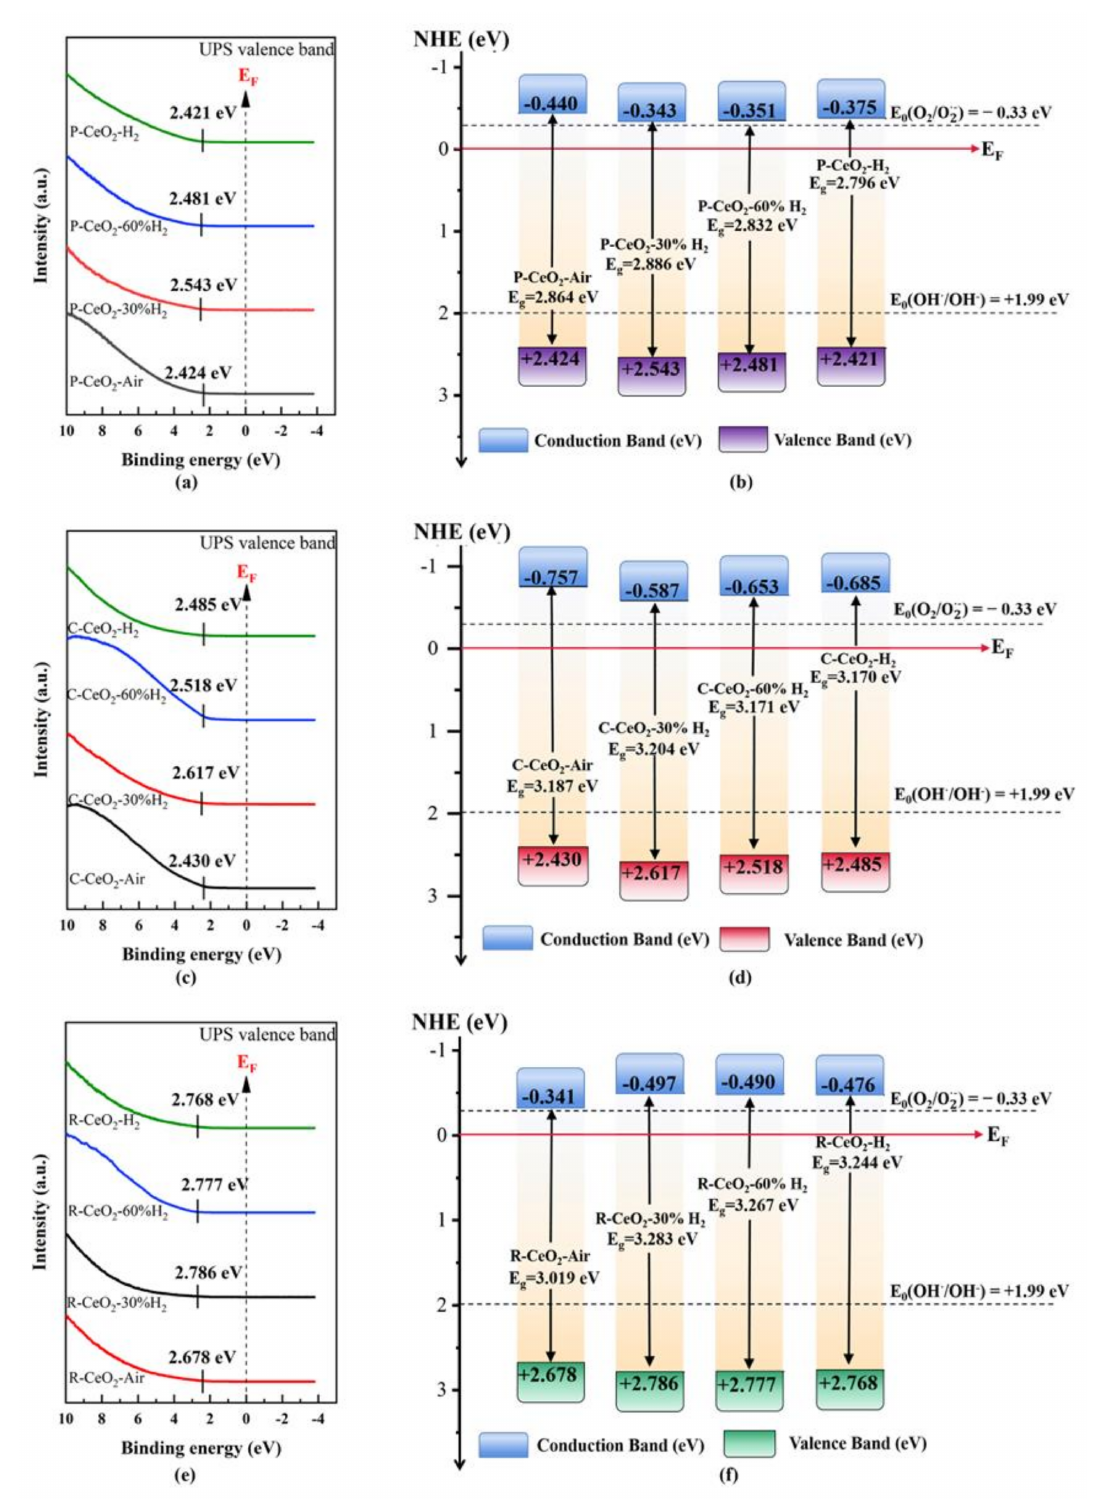
Figure 7. UPS valence band spectra and energy band gap schematic diagram of P-CeO 2 ( a , b ), C-CeO 2 ( c , d ), and R-CeO 2 ( e , f ) annealed in different concentration of H 2